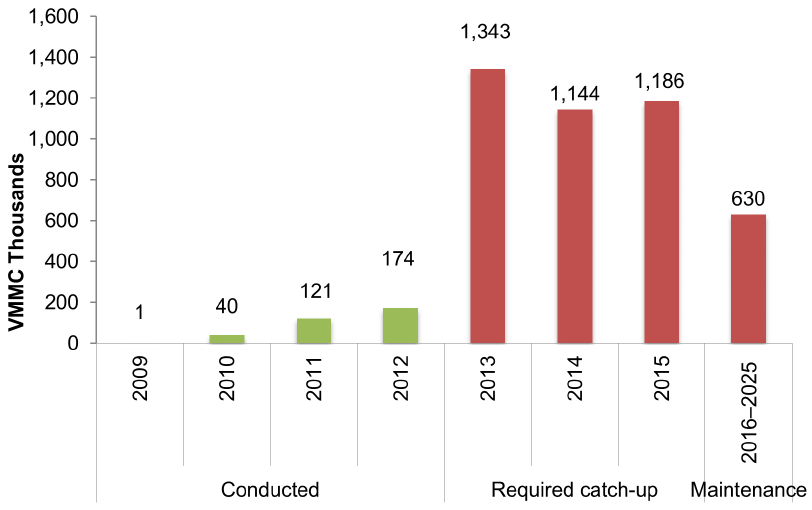
Figure 3. Annual number of new HIV infections baseline and with VMMC scale-up (2009–2025).